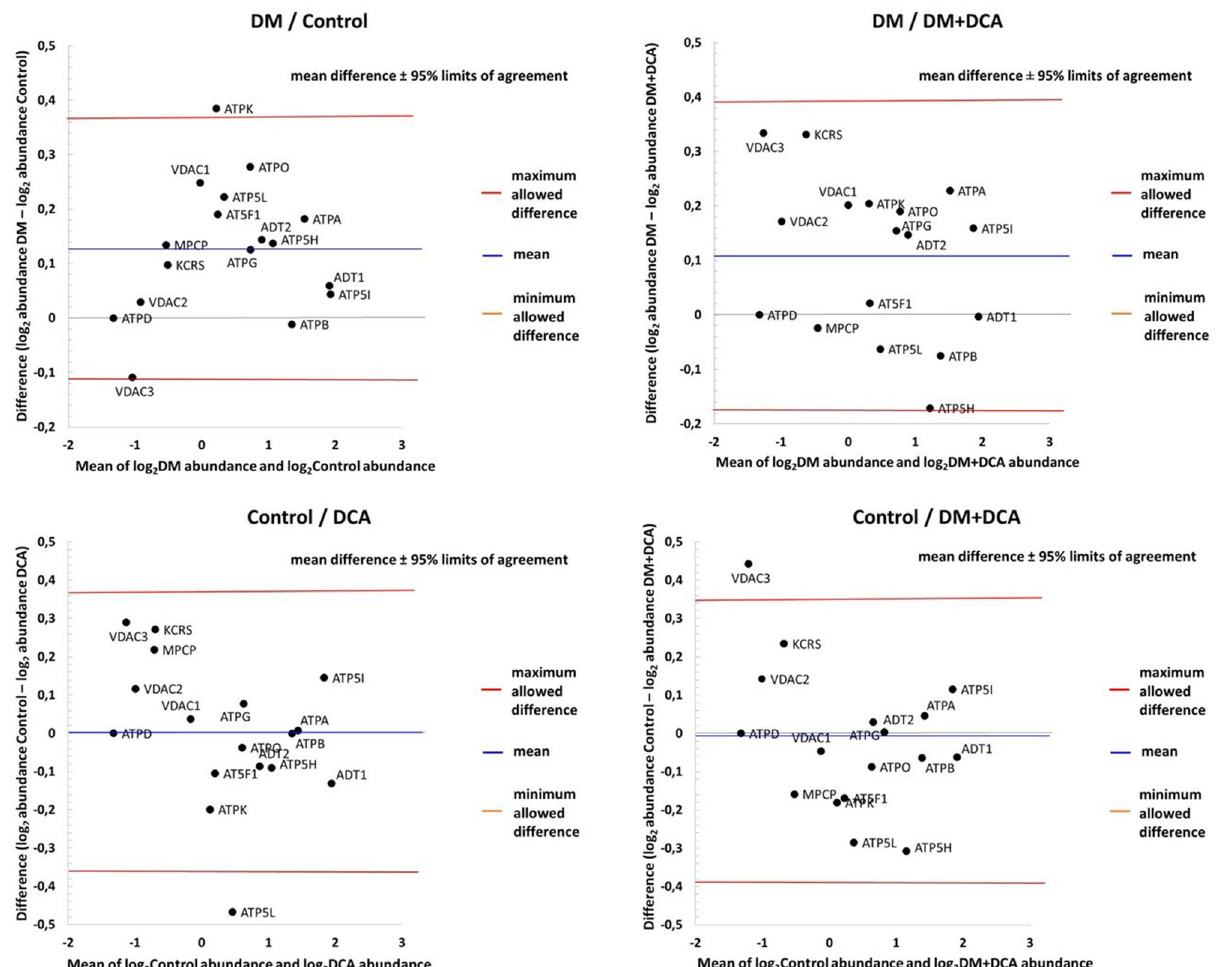
Figure 5. Scatter diagrams of the difference between the abundances of identified proteins involved in the structure and regulation of mPTPs in the two different experimental conditions plotted against the average of the two measurements, both on a log scale. We compared the differences between Groups DM versus Control (graph top left), DM versus DM + DCA (graph top right), Control versus DCA (graph bottom left) and Control versus DM + DCA (graph bottom right). Horizontal lines are drawn at the mean difference and at the limits of agreement (DM vs. Control: 95% LoA − 0.1099 to 0.3634; DM vs. DM + DCA: 95% LoA − 0.1795 to 0.3919; Control vs. DCA: 95% LoA − 0.3607 to 0.3662; Control vs. DM + DCA: 95% LoA − 0.3872 to 0.3461). The line of the mean clearly shows an absolute systematic difference (0.1268 for DM versus Control; 0.1062 for DM versus DM + DCA; 0.0028 for Control versus DCA and − 0.0205 for Control versus DM + DCA) for the investigated mPTP protein components (n = 17) in the two conditions (paired t test p value = 0.0005 for DM